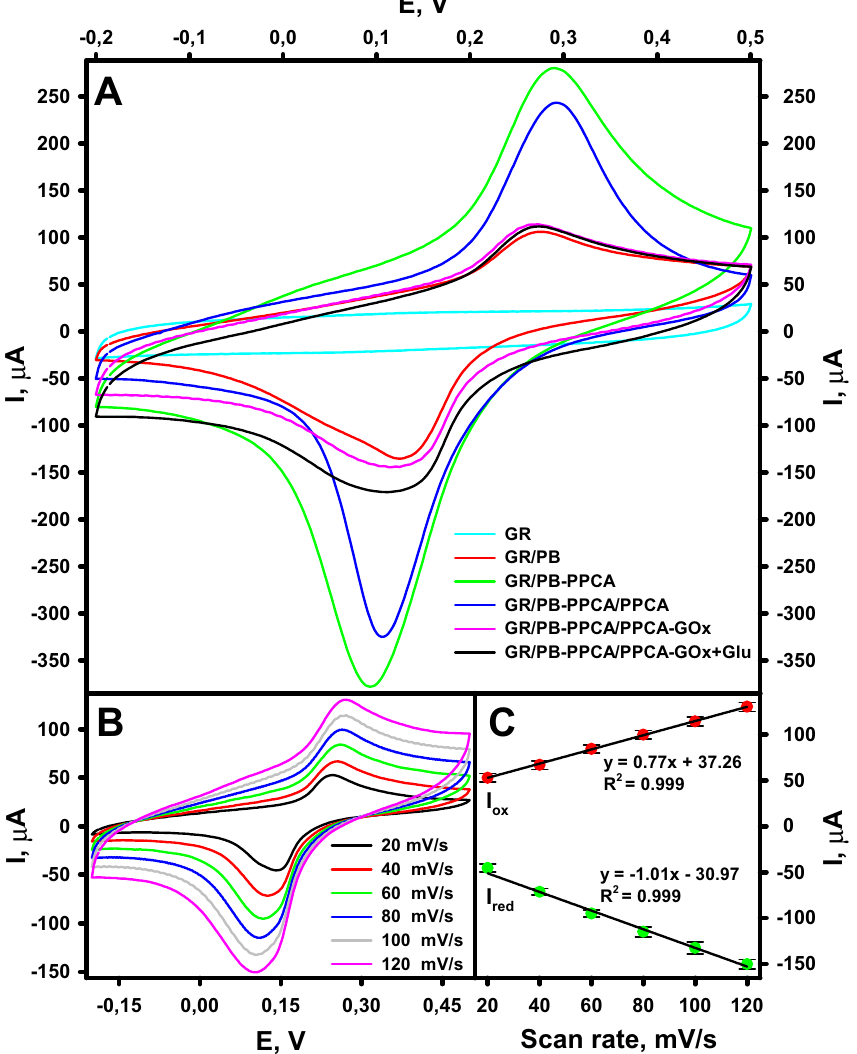
Figure 4. (A) Cyclic voltammograms for electrodes obtained after an appropriate step of the biocathode preparation process recorded in pure A-PBS-KCl, pH 6.0, or in 10 mM glucose (Glu) solution in A-PBS-KCl, pH 6.0, at a scan rate of 100 mV/s. (B) Cyclic voltammograms for biocathode recorded in A-PBS-KCl, pH 6.0, at various scan rates. (C) Plots of peak current vs scan rate.